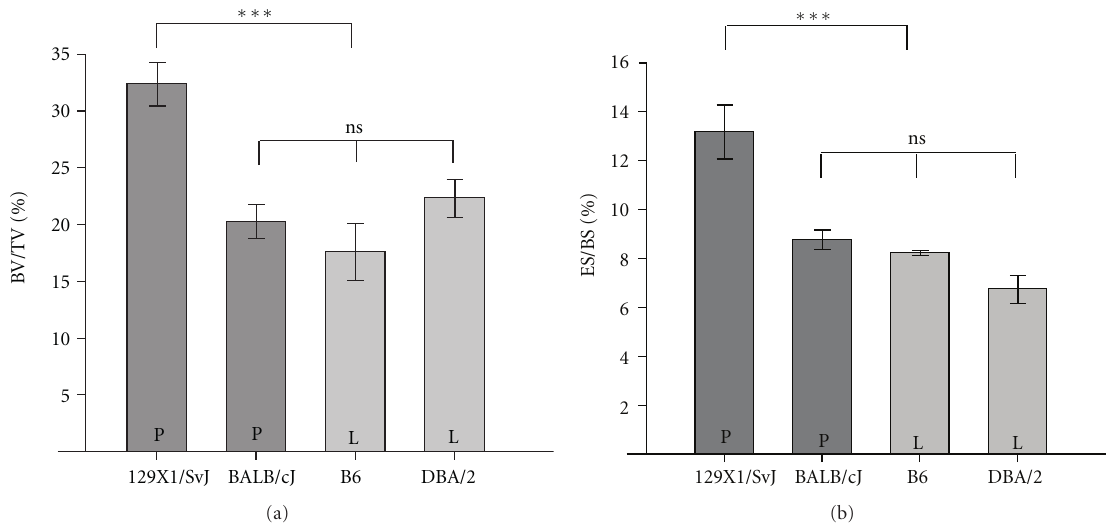
Figure 2: Histomorphometric analysis of the vertebrae in the strains 129X1/SvJ, BALB/cJ, B6, and DBA/2 displayed as means ± SEM. P and L refers to P451 and 451L, respectively. (a) The BV/TV% of 129X1/SvJ was between 32% and 46% lower than the BV/TV% in the other strains. (b) The percentage of eroded surfaces (ES/BS%) was nearly 50% higher in the 129X1/SvJ strain compared to the other strains.